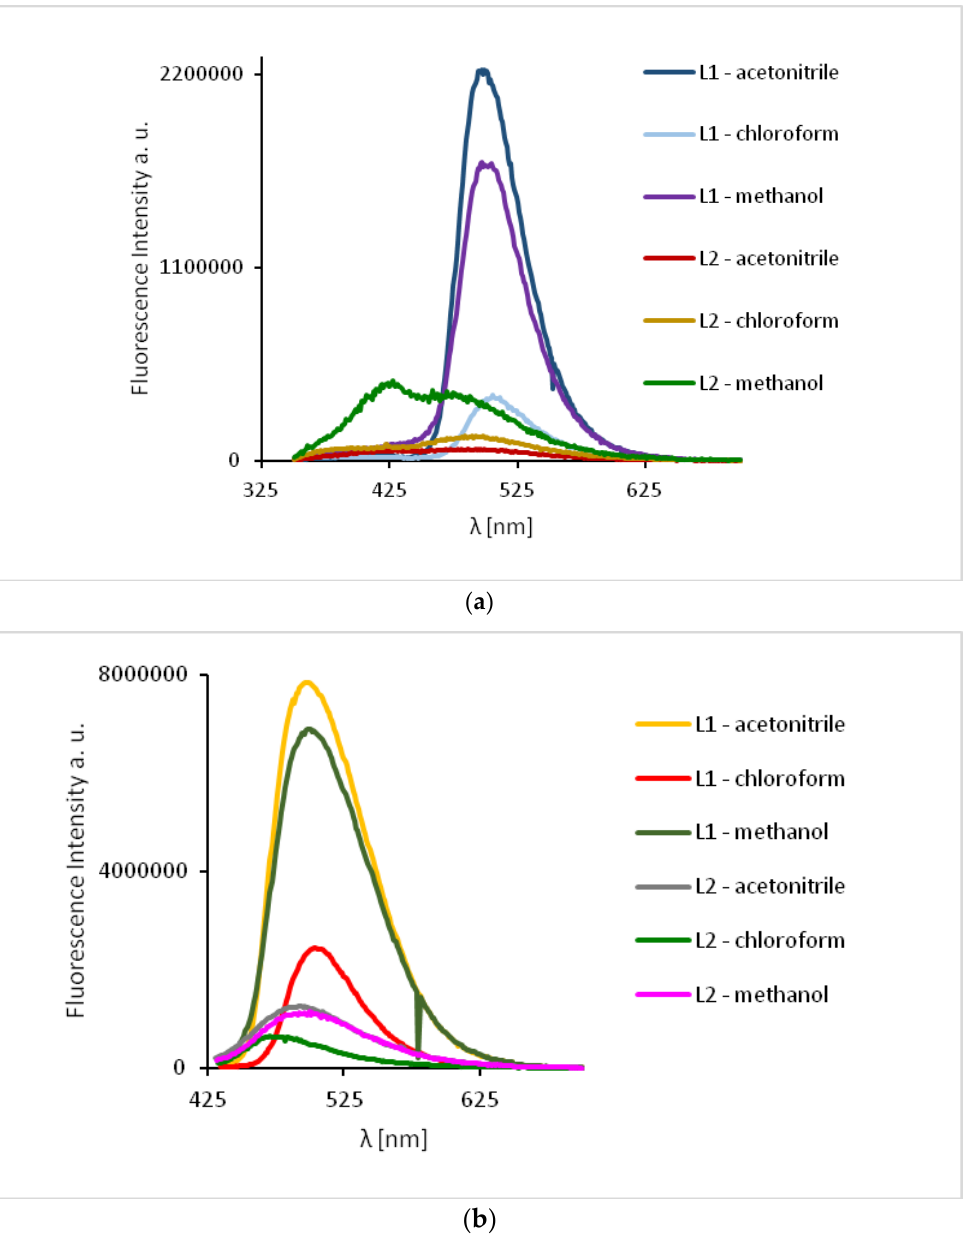
Figure 10. Solution emission spectra of ligands HL1 and HL2 . ( a ) λ ex = 296 nm, ( b ) λ ex = 422 nm, (MeCN, chloroform and methanol 1 × 10 −4 mol/dm 3 , RT).